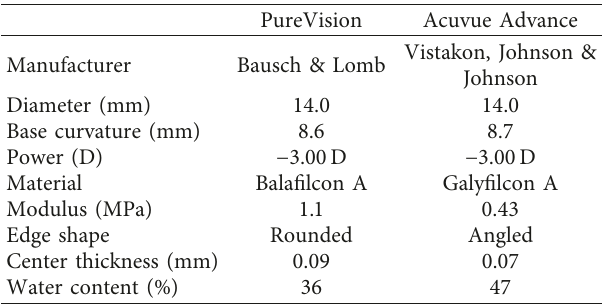
Table 1: Design parameters of contact lenses measured in the